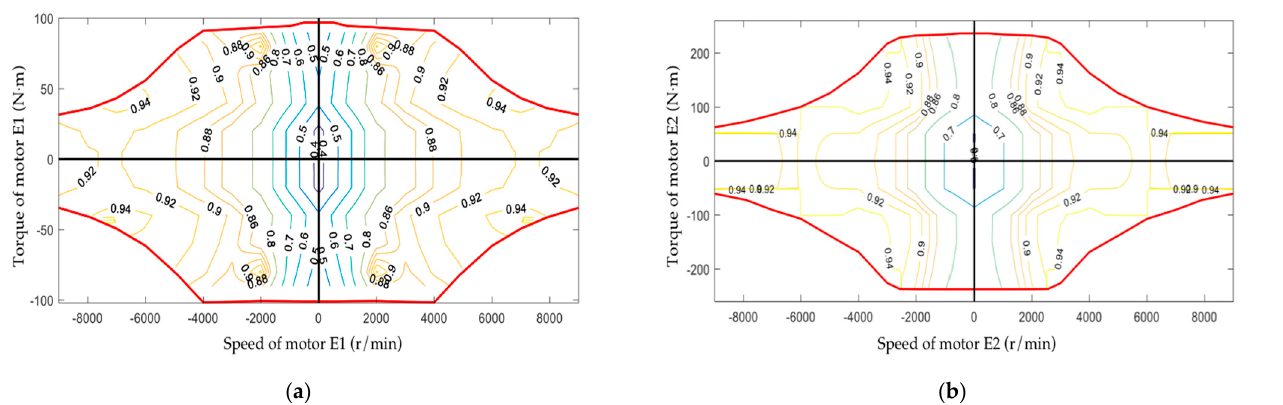
Figure 4. The efficiency map of two motors: ( a ) motor E1; ( b ) motor E2.